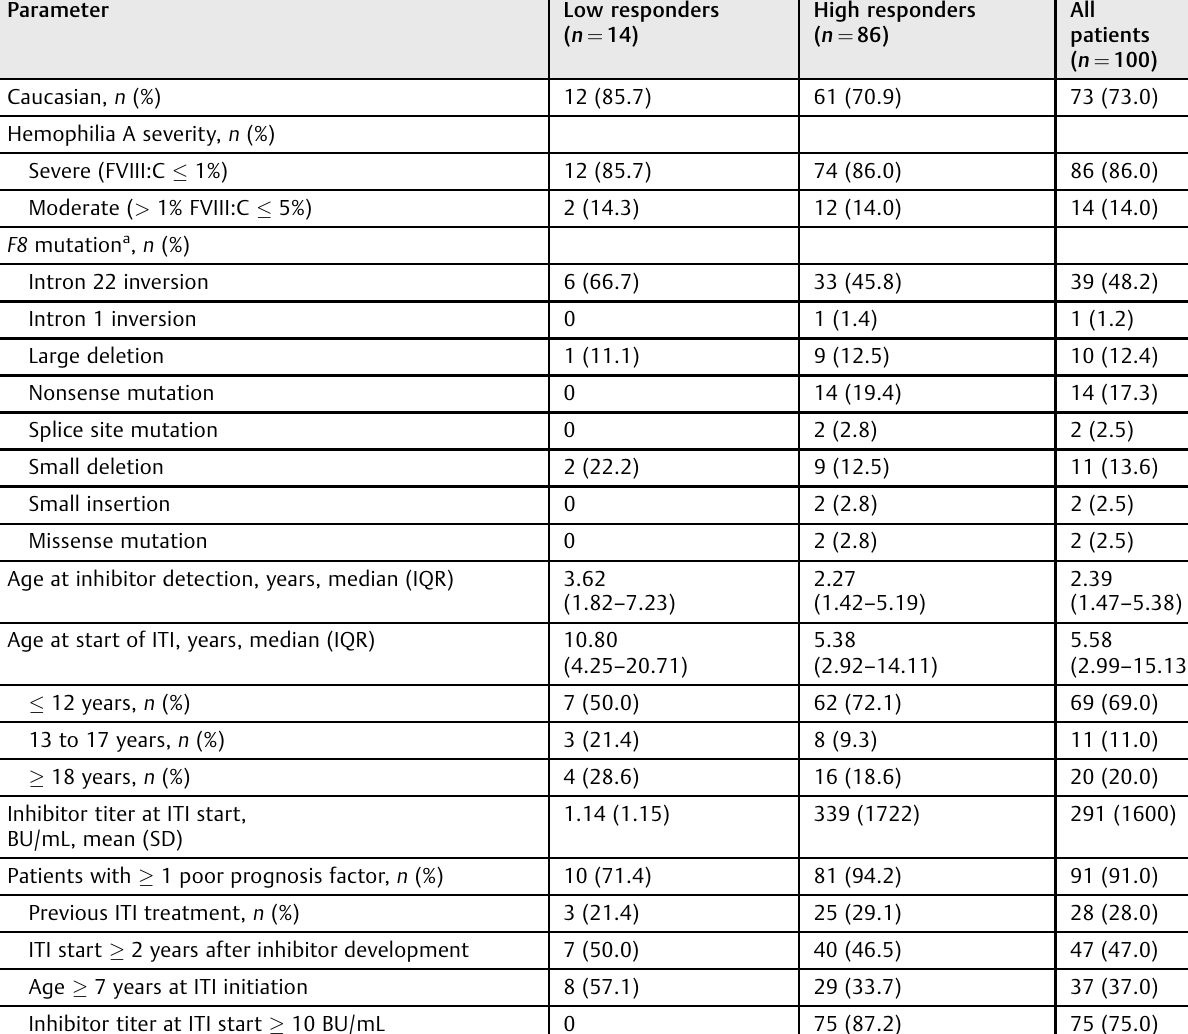
Table 1 Patient demographics and baseline clinical characteristics